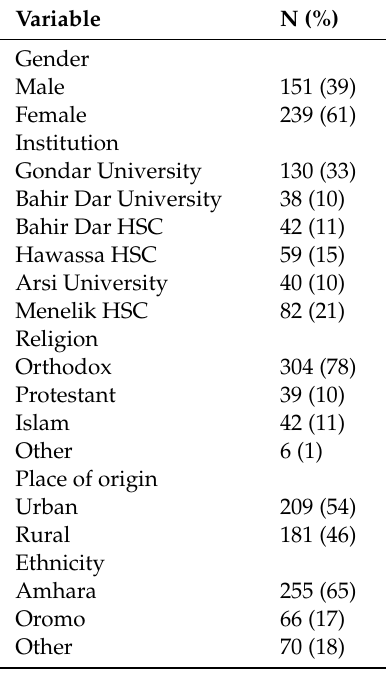
Table 1. Background characteristics of the study population (N =